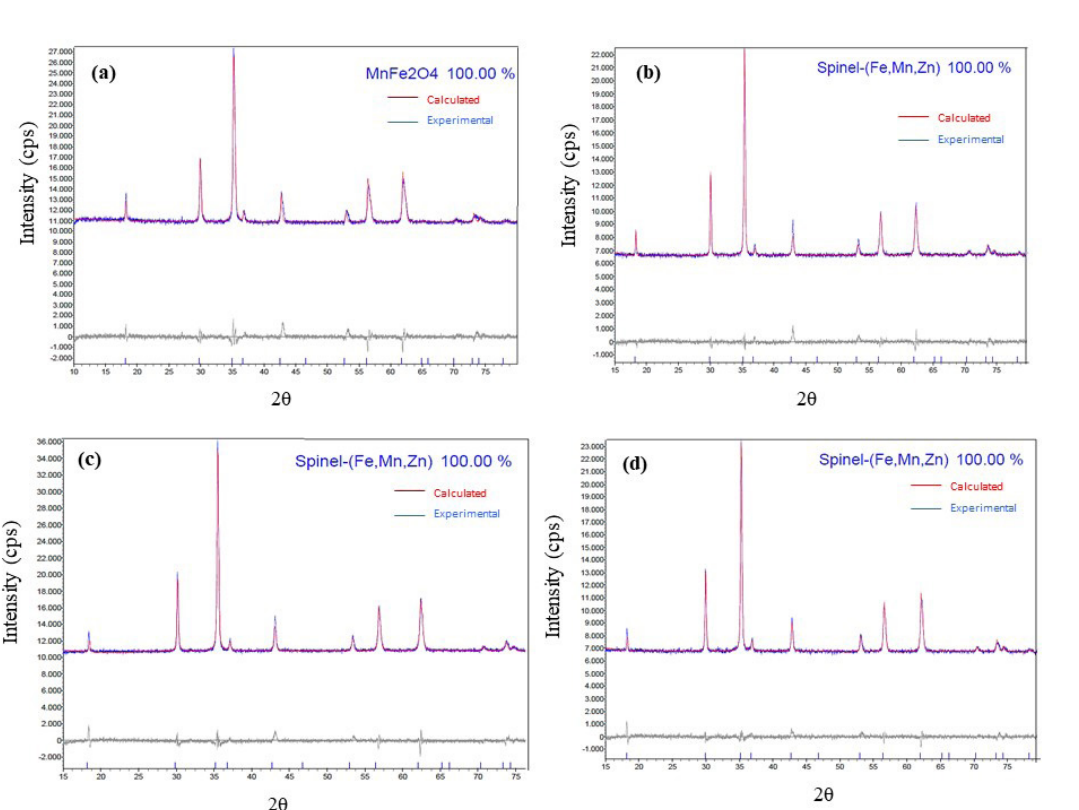
Figure 3. X-ray difratograms with Rietveld refinement with compositions (a) x = 0, (b) 0.35, (c) 0.5 and (d)